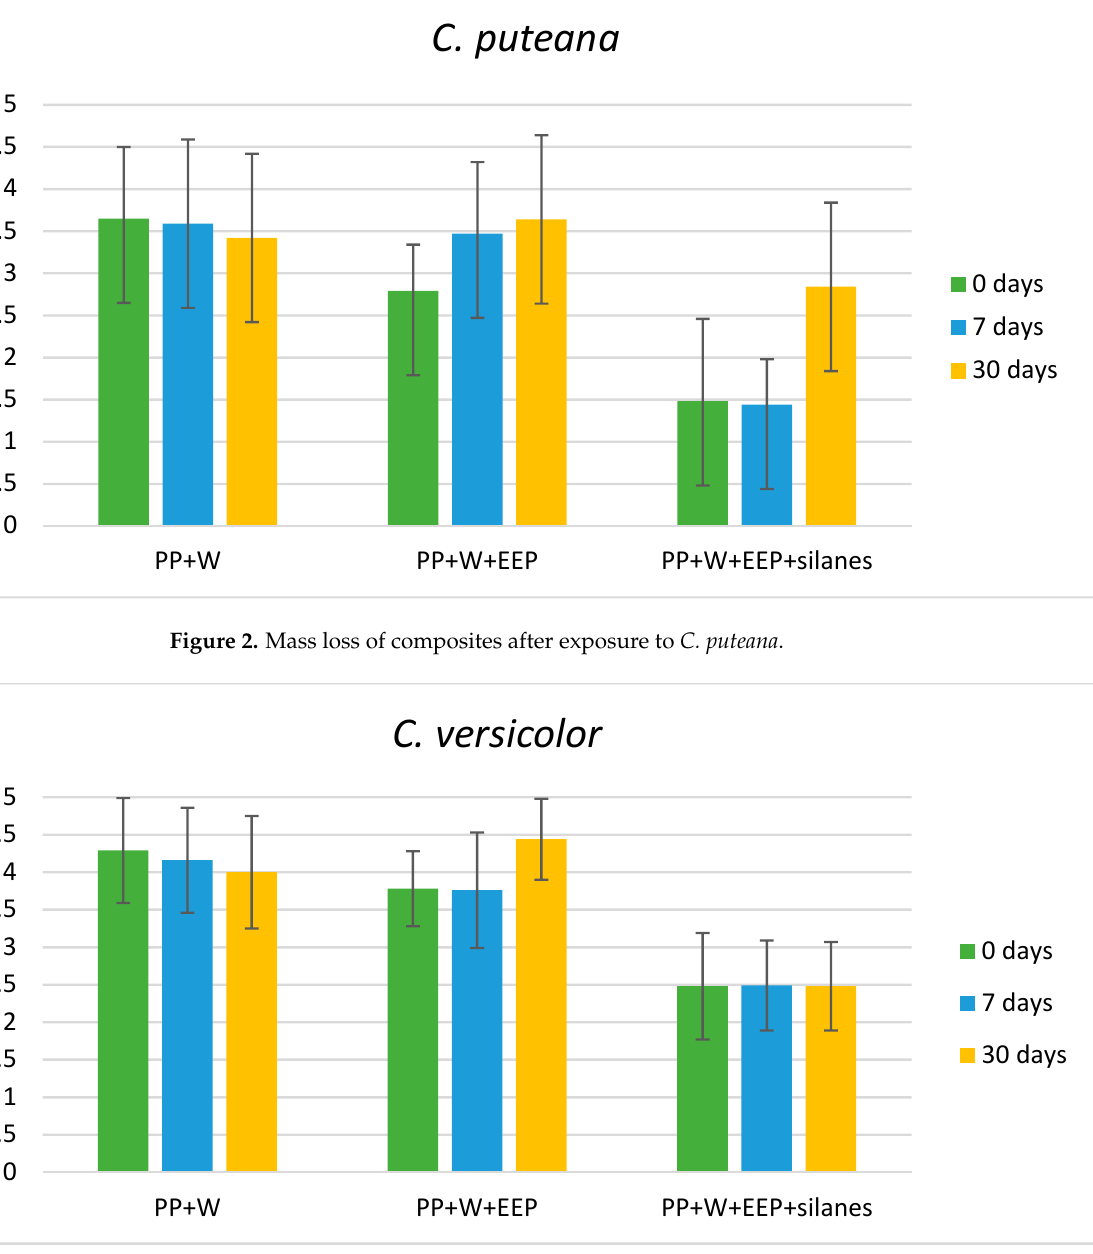
Figure 3. Mass loss of composites after exposure to C. versicolor